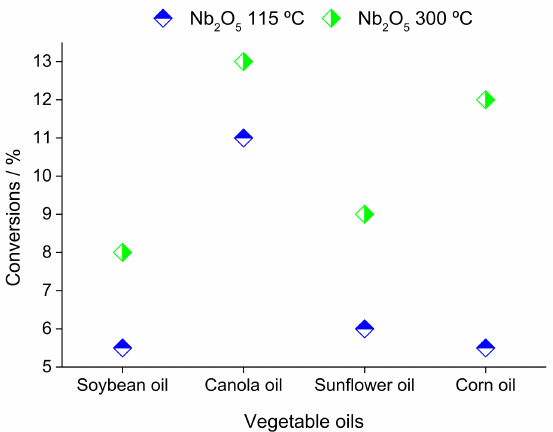
Figure 20. Transesterification of different oils with methyl alcohol over thermally treated Niobium oxides. Reaction conditions: methyl alcohol:vegetable oil molar ratio (3:1), catalyst (20% in relation to the oil mass), reaction temperature (170 ◦ C), time (48 h) (adapted from